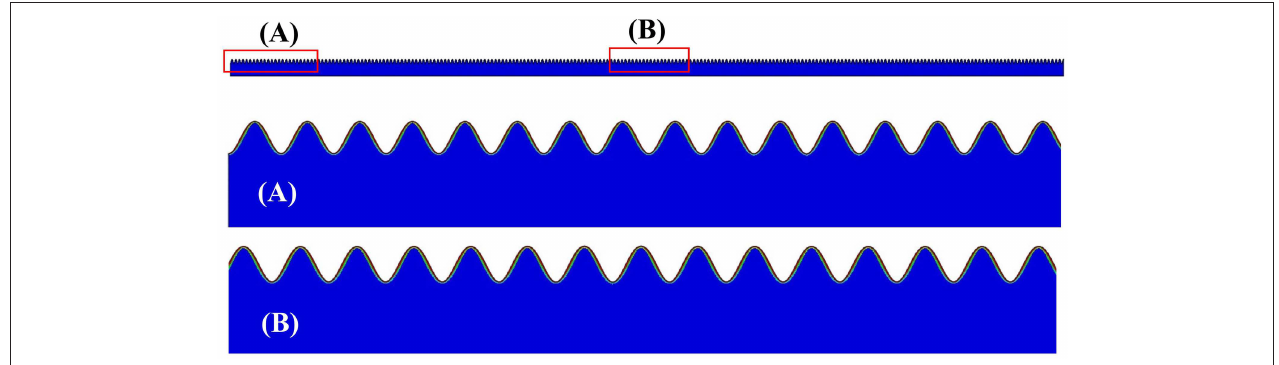
FIGURE 12 | Typical wrinkling configurations on the entire surface region, obtained from the simulations for the models with a bilayer film, and with the imperfection ≤ 55. (A) Magnified portion of the film near the edge. (B) Magnified portion of the film in the middle section. distributions satisfying the condition of 10 ≤ S imp λ s